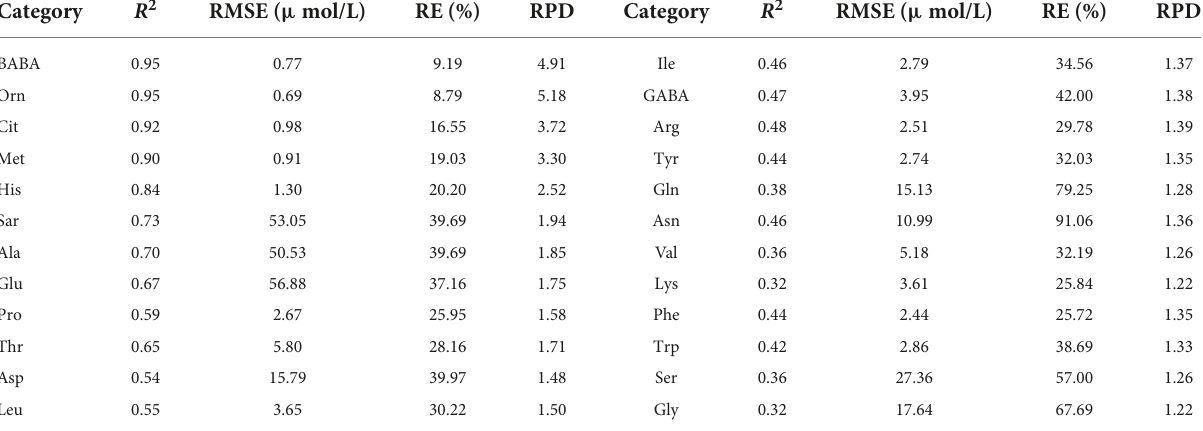
TABLE 4 Evaluation results of PLSR model using test set for various amino acid contents based on the reflectance of sensitive bands.